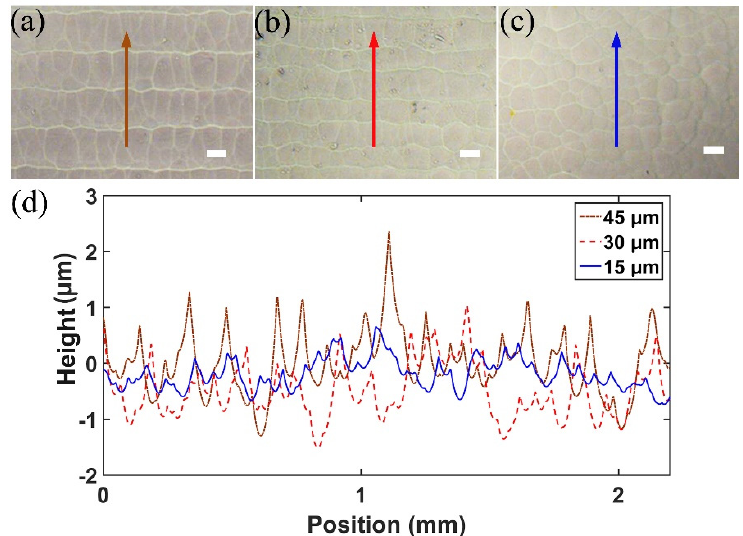
Figure 4. Surface morphologies measured on samples written with the slice thicknesses set at ( a ) 45 μ m; ( b ) 30 μ m; and ( c ) 15 μ m. ( d ) The measured 1D surface profiles of the samples in (a), (b), and (c) are shown by the brown dotted, red dashed, and blue solid lines, respectively. Scale bar: 25 μ m.